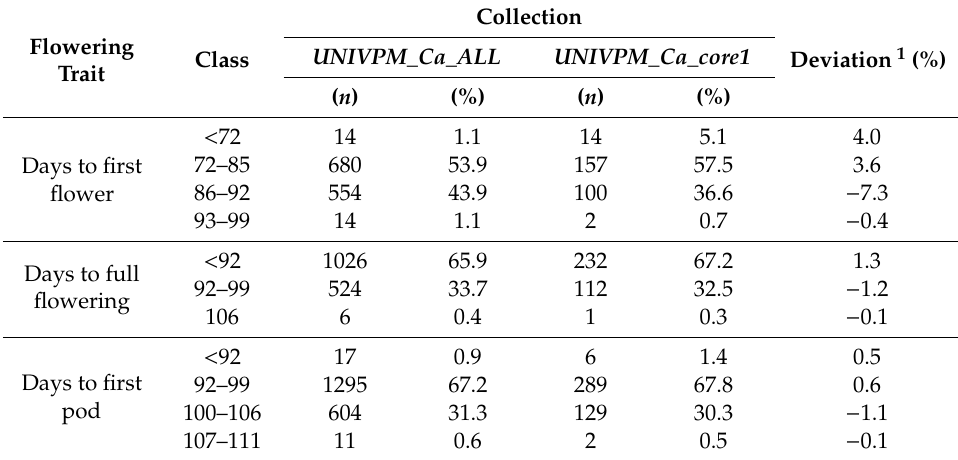
Table 5. Number of accessions and relative frequencies of UNIVPM_Ca_ALL and UNIVPM_Ca_core1 for flowering